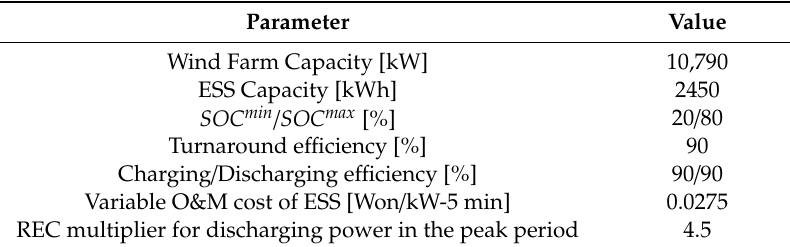
Table 1. Key parameters of a wind farm and ESS